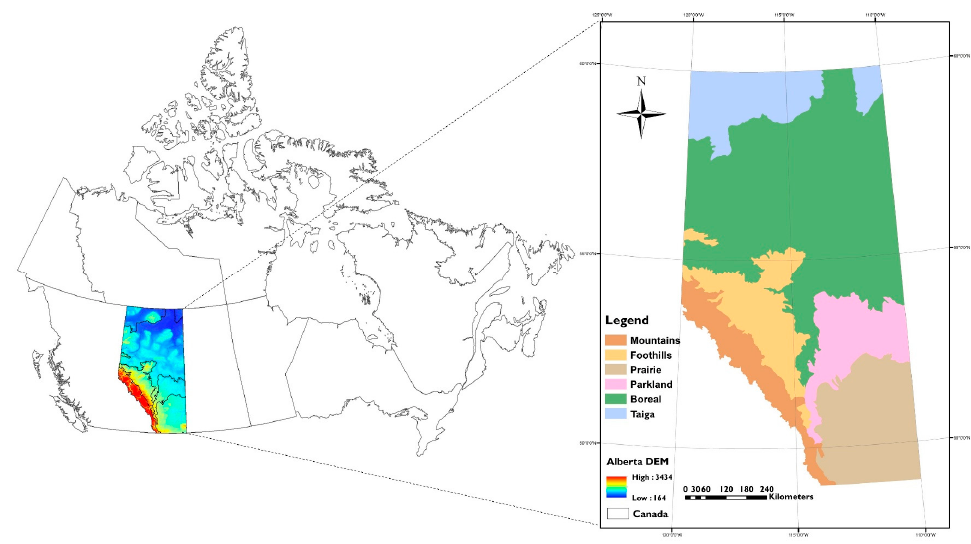
Figure 1. Six ecozones in Alberta—Mountain, Foothills, Prairie, Parkland, Boreal, and Taiga.